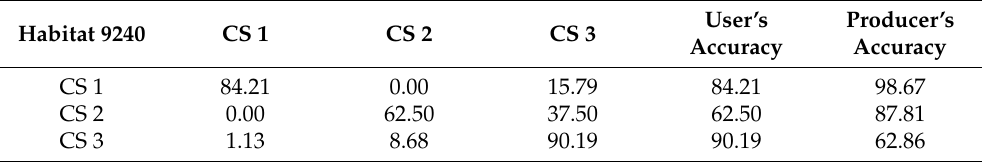
Table 9. Confusion matrix for the most accurate classification model using ALS data after validation for habitat 9240. Values are shown in %. CS stands for conservation status. Additionally, 9160 is Quercus robur habitat, 9230 is Quercus pyrenaica habitat, and 9240 is Quercus faginea